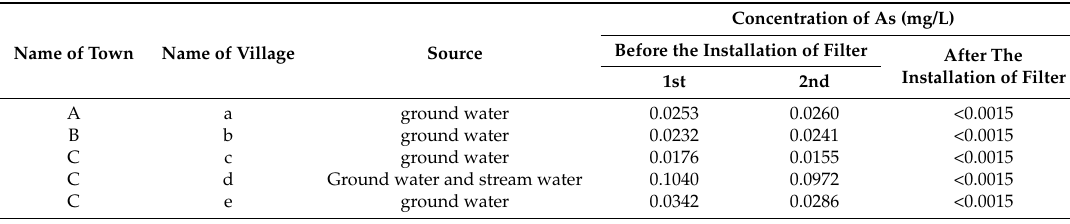
Table 6. Arsenic concentration in drinking water from the